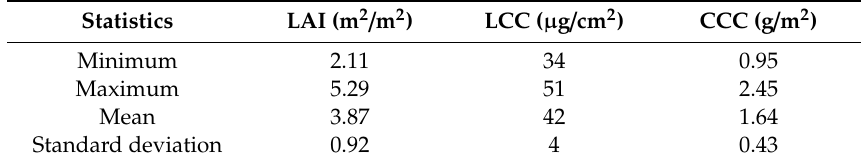
Table 1. Descriptive statistics of the in situ measurements: leaf area index (LAI), leaf canopy content (LCC) and canopy chlorophyll content (CCC) (n = 30). Ten of the 40 plots were not included in the analysis as they were outside the image extent or covered by